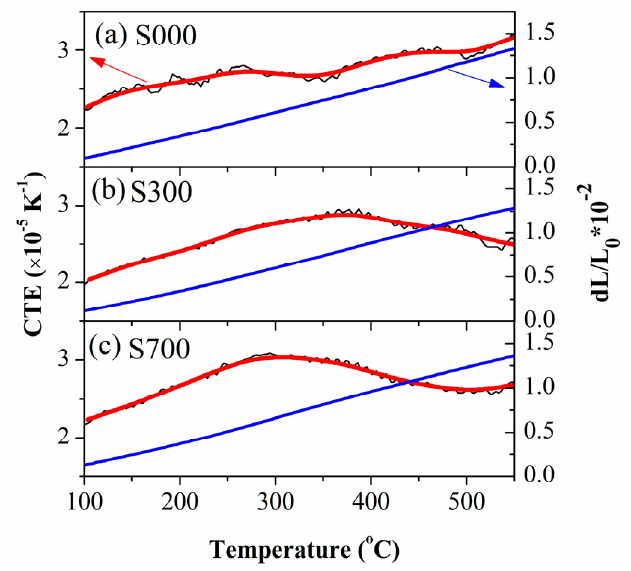
Figure 3. Thermal expansion curves (blue) and the variation of experimental coefficient of thermal expansions (CTE) (red) for ( a ) base metal (S000) as well as ( b ) S300 and ( c ) S700 FSP